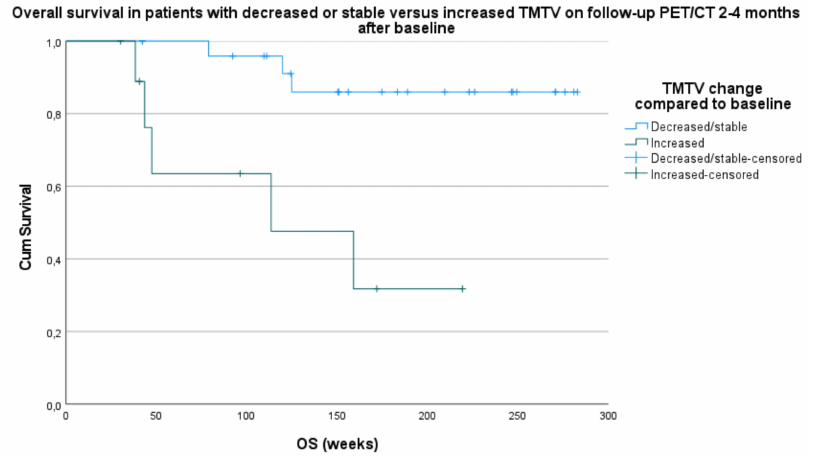
Figure 2. Survival analysis based on overall survival (OS) in patients with stable/decrease in TMTV versus increase in TMTV on follow-up PET/CT 2–4 months after baseline compared to TMTV on baseline